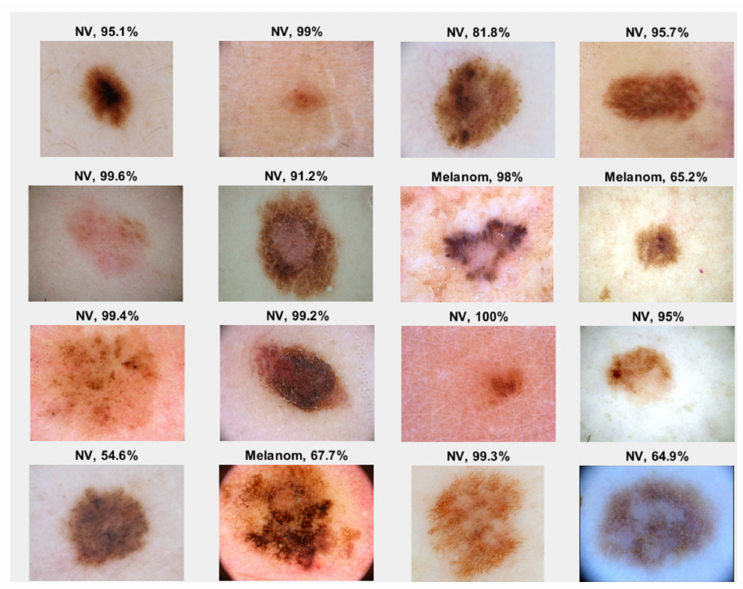
Figure 21. Validation images with predicted labels and predicted probabilities in the case of ResNet-101.